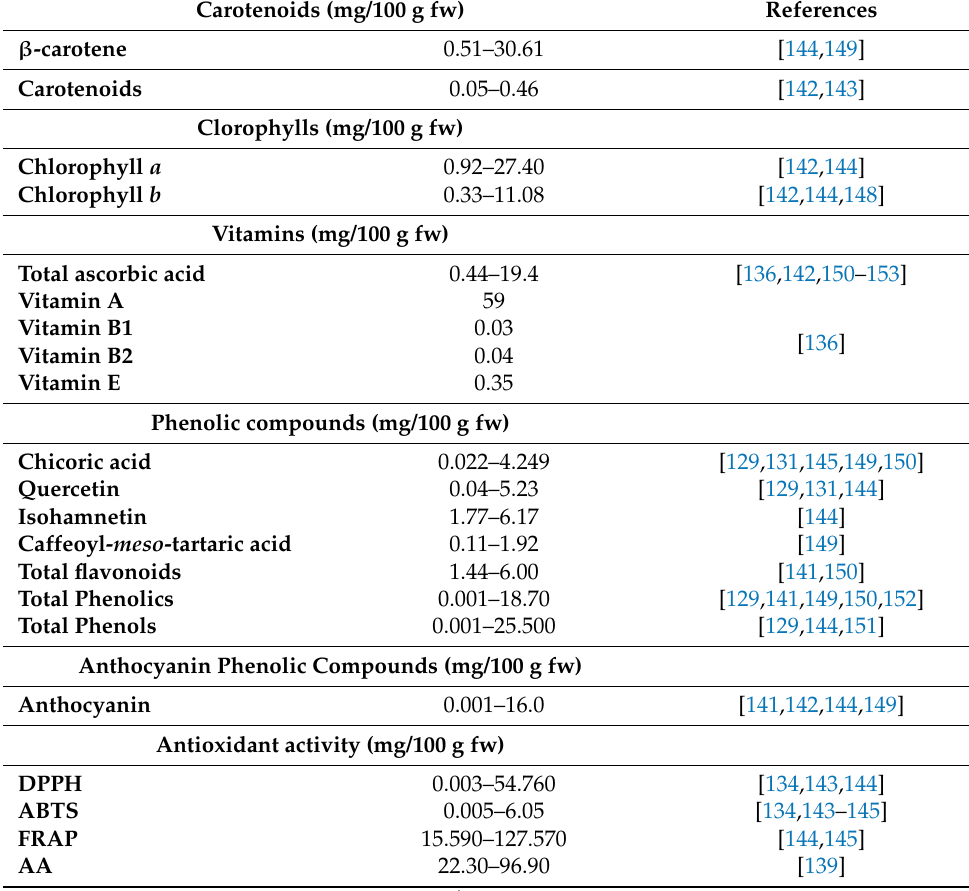
Table 6. Carotenoids, vitamins, phenolic and bioactive compounds of Lactuca sativa